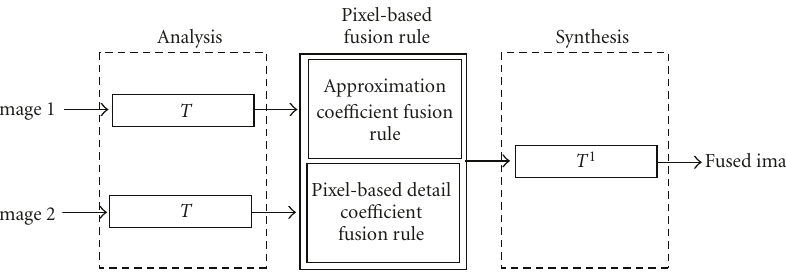
Figure 3: A generalized pixel-based multiresolution image fusion